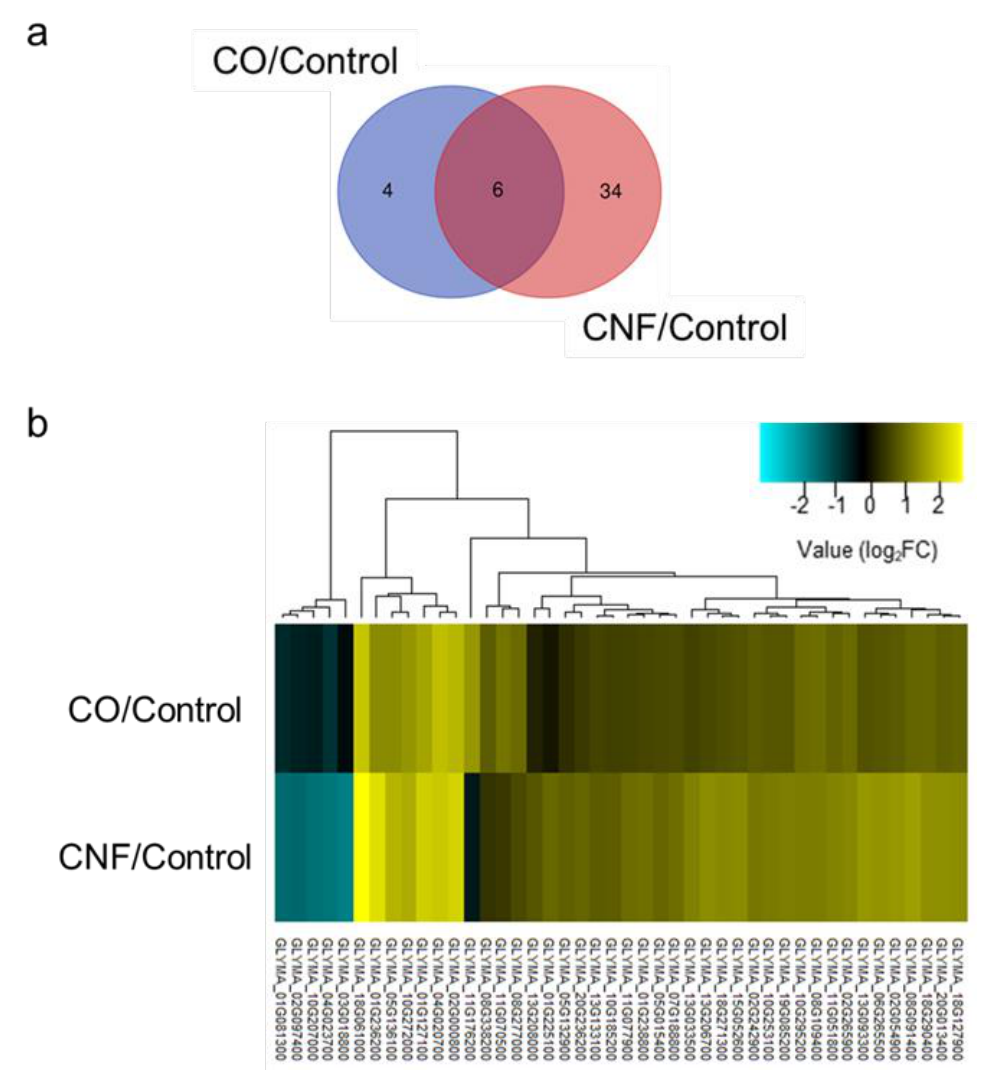
Figure 2. Differential expression analysis in chitin oligosaccharides (CO)- and chitin nanofiber (CNF)-treated soybean plants. Venn diagram ( a ) and clustered heatmap ( b ) of all differentially expressed genes.